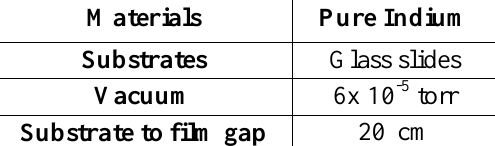
Table 1: Parameters for fabrication of In O thin 2 3